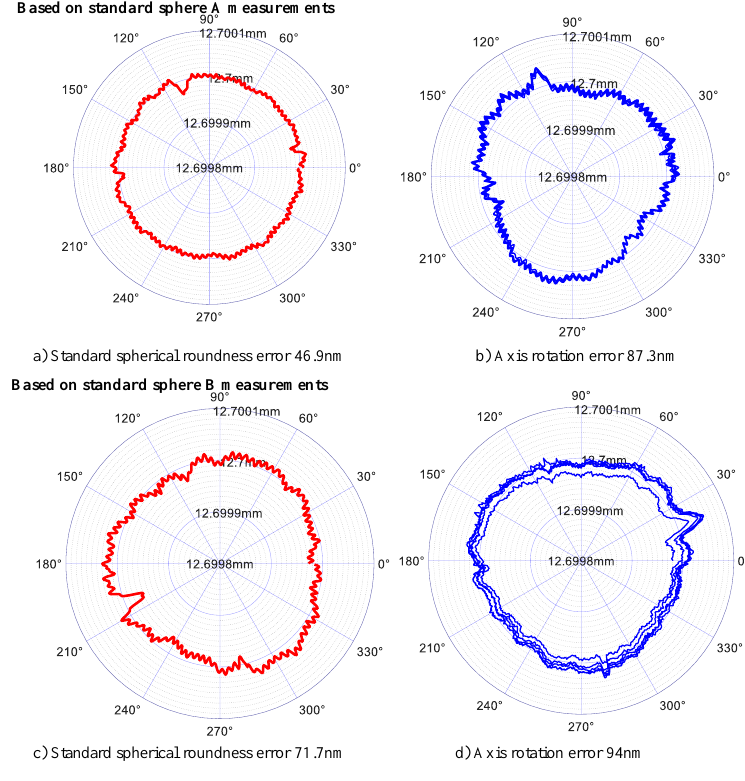
Table 3. standard sphericity separation error (standard sphere B) (nm).